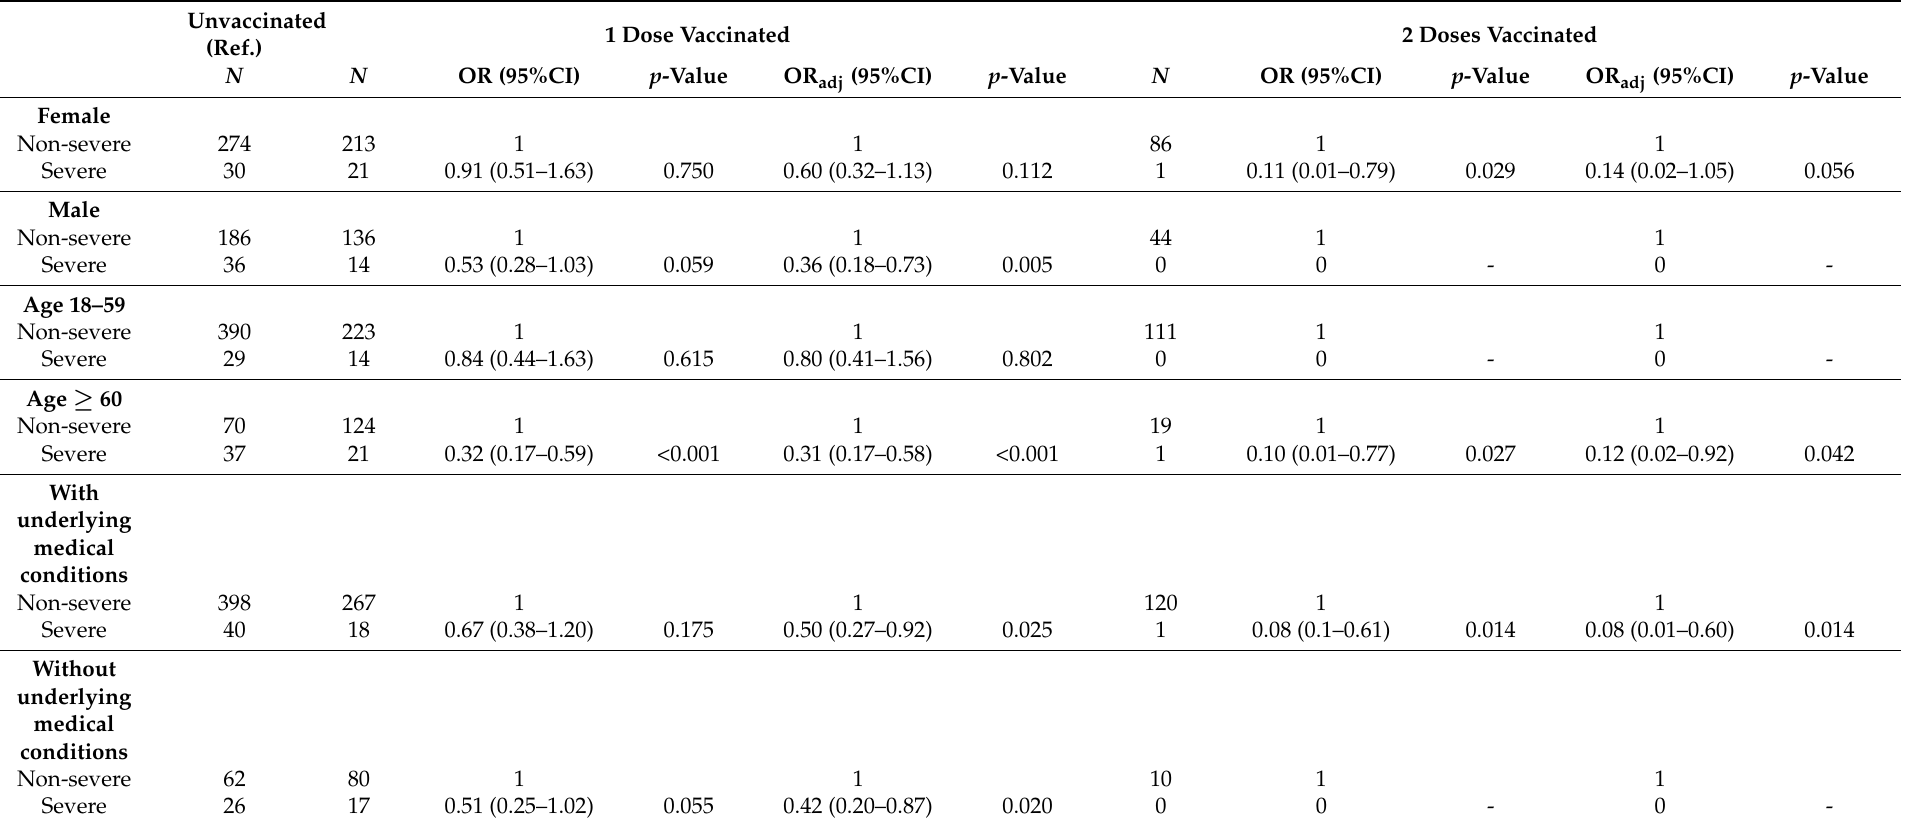
Table 4. Estimate the effect of vaccines against severe disease stratified by sex, age, and underlying medical condition. Unvaccinated